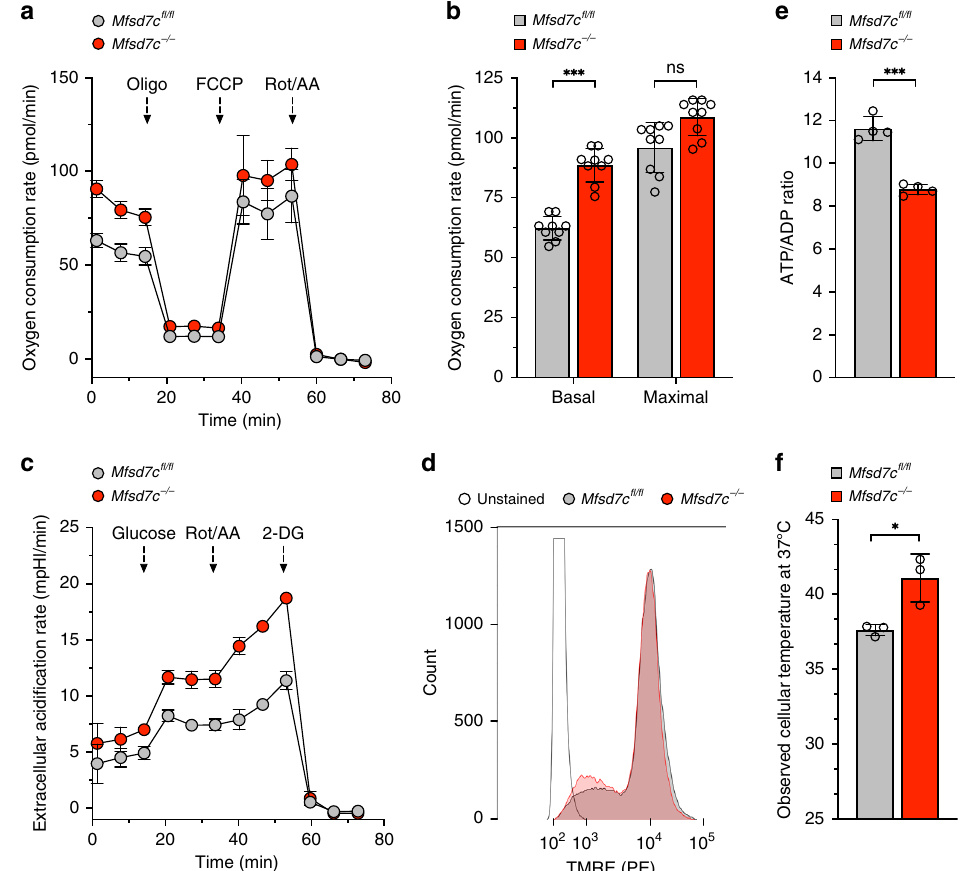
Fig. 3 Loss of Mfsd7c stimulates OCR, ECAR, and thermogenesis in BMDM. Bone marrow-derived macrophages (BMDM) were derived from exon 2 fl oxed ( Mfsd7c fl / fl ) C57BL/6 mice and C57BL/6 mice with exon 2 deletion in macrophages ( Mfsd7c − / − ). a , b Representative OCR analysis from Mfsd7c fl / fl and Mfsd7c − / − macrophages as measured by Seahorse XF96e Analyzer and their responses to oligomycin (oligo), FCCP, and rotenone plus antimycin A (Rot/AA) ( n = 3 technical replicates) ( a ), and their average basal and maximal OCR ( b ) ( n = 9 independent experiments from 3 biological replicates). c Representative ECAR analysis of Mfsd7c fl / fl and Mfsd7c − / − macrophages and their responses to glucose, Rot/AA, and 2-deoxyglucose (2-DG) ( n = 3 technical replicates). d Mitochondrial membrane potential of Mfsd7c fl / fl and Mfsd7c − / − macrophages analyzed with TMRE staining followed by fl ow cytometry (1 representative histogram picked from 3 biological replicates). e Cellular ATP/ADP ratio, ( n = 4 biological replicates from average of 5 technical replicates). f Estimates of cellular temperature of Mfsd7c fl / fl and Mfsd7c − / − macrophages as measured by fl uorescent thermoprobe ( n = 3 biological replicates). p values were calculated using unpaired t -test (* p <0.05, ** p <0.01, *** p <0.005). Data are presented as mean value±standard